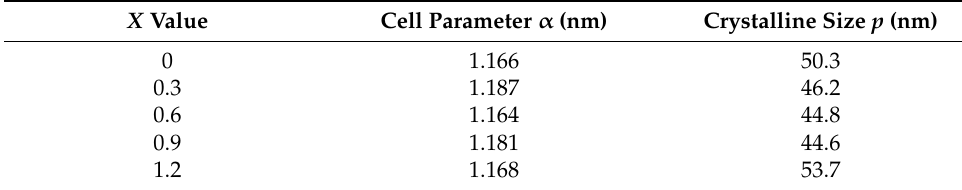
Figure 3. X-ray diffraction spectrogram of ( A ) calcined samples and ( B ) (222) planes of calcined samples. Table 1. The grain size of K x CsCuNH 4 PAV after calcination.